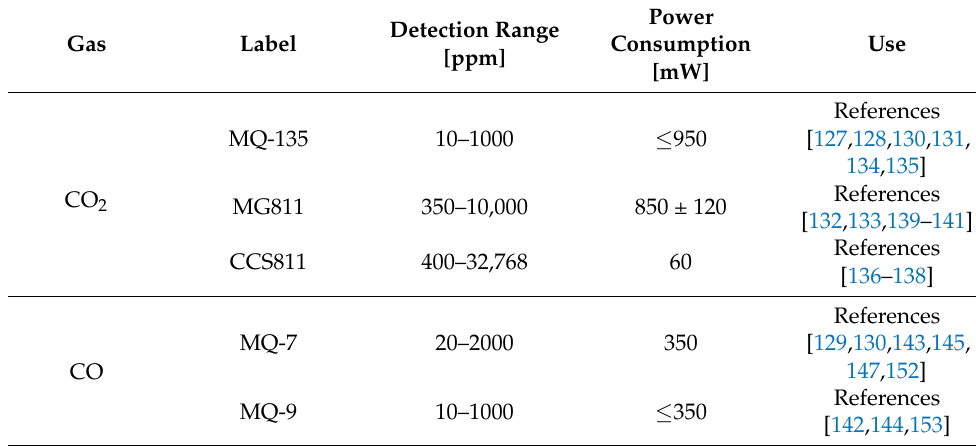
Table 5. Review of gas sensors with main